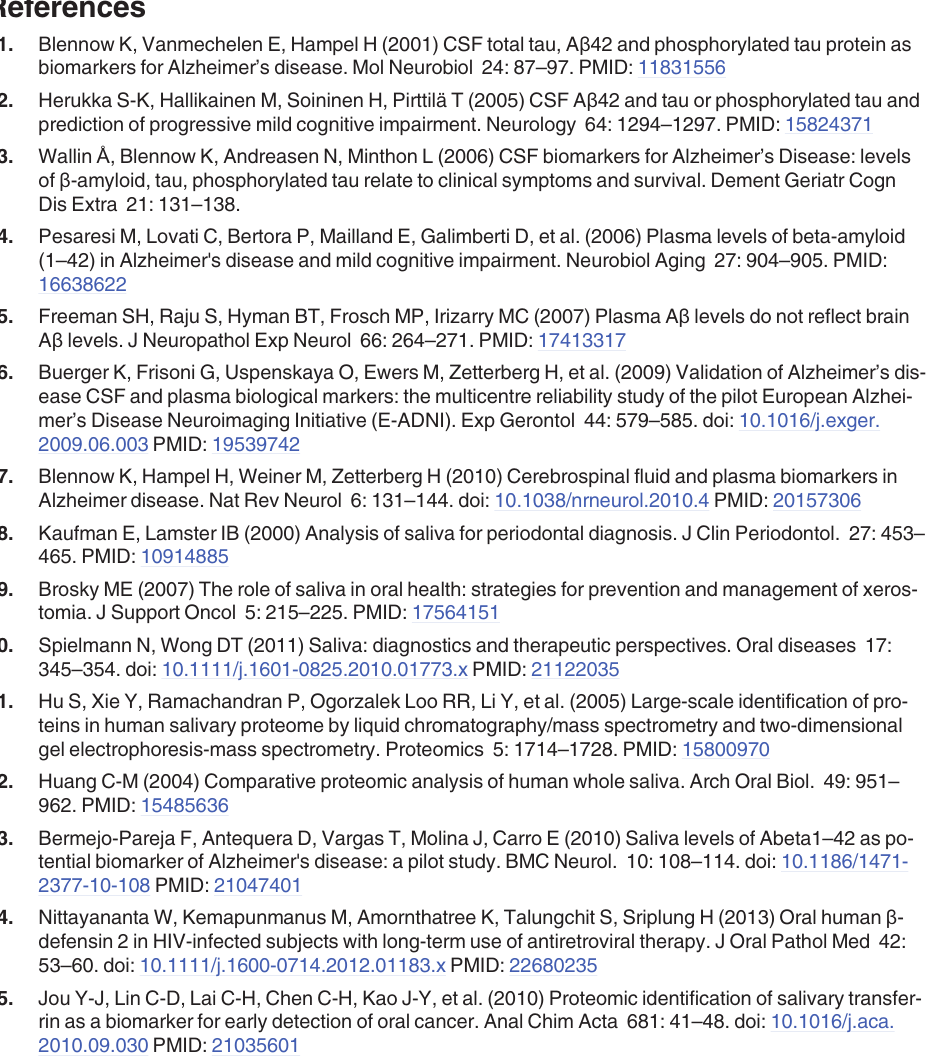
after it was normalized to the values obtained from control cells. Data are presented as median. Figure D. Change of currents for sensing and control cells using EG-ISFET biosensor. The change of current generated from the sensing and control cells from saliva samples. Data are presented as